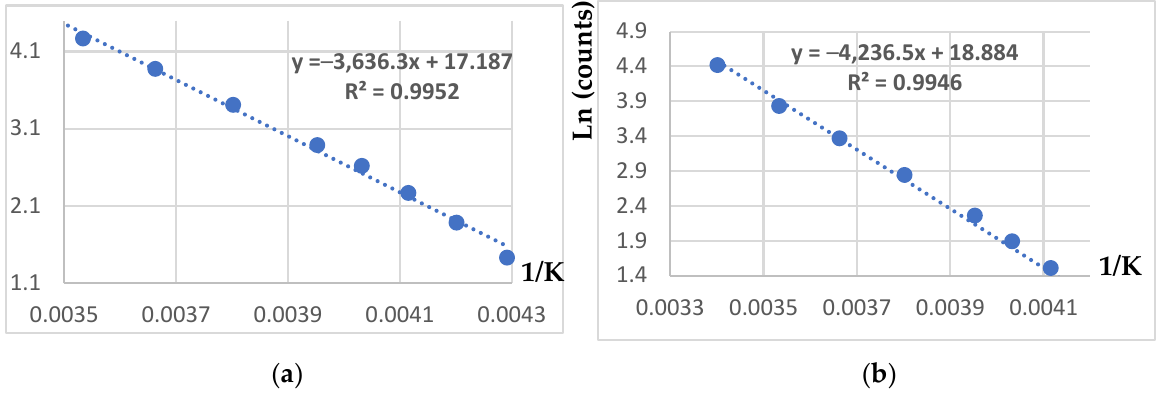
Figure 8. Dependence of the natural logarithm of the background current of the sensor with the corresponding electrolyte sample on the reciprocal temperature, along the abscissa axis is 1/K, along the ordinate axis, the value of Ln (counts), the count is proportional to the current value in µ A: ( a ) For the electrolyte sample #4 Water/KI/ PC, J 2 = 0.01 mol/liter; ( b ) For the electrolyte sample #5 Water/LiI/PC, J 2 = 0.01 mol/liter.